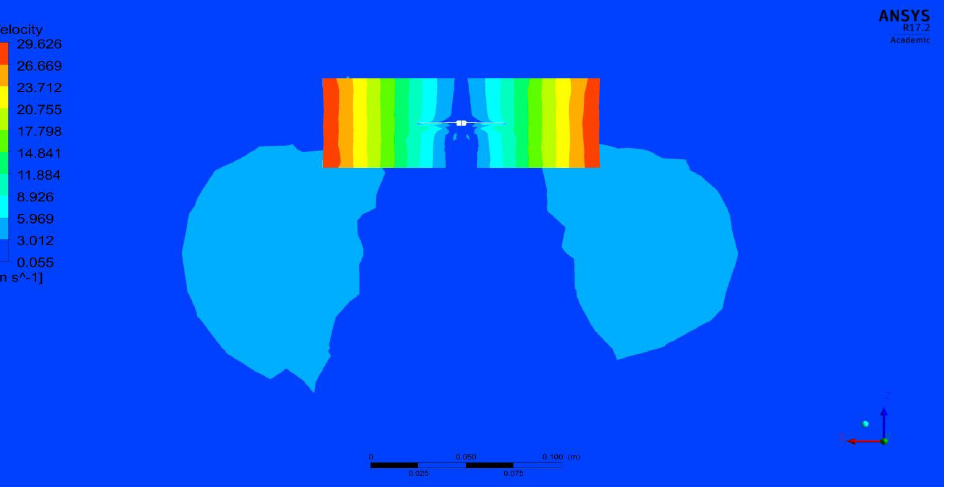
Figure 47. A typical planar representation of hydrodynamic velocity variations over the UAV propeller under the conditions of 3 m/s and 4000 RPM.